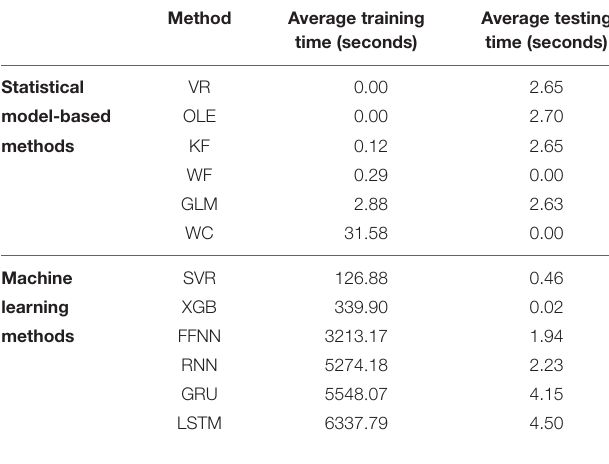
TABLE 1 | The average training time and testing time is shown for each decoding method grouped by category, model-based methods (above) and machine learning methods